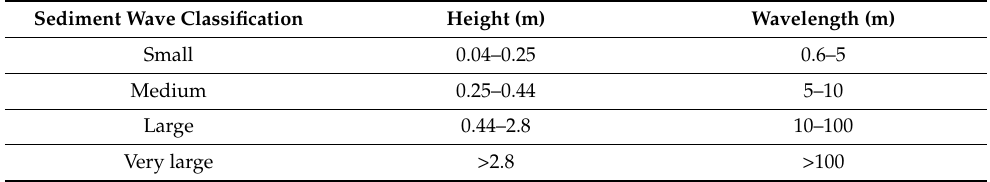
Table 3. Sediment wave size classification scheme used in this study. Source: Van Landeghem, et al. [56] and Evans, et al. [79], originally adapted from Ashley [46] and Berne, et al.